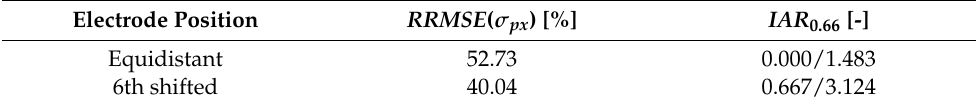
Table 3. The electrode placement error in the conductivity